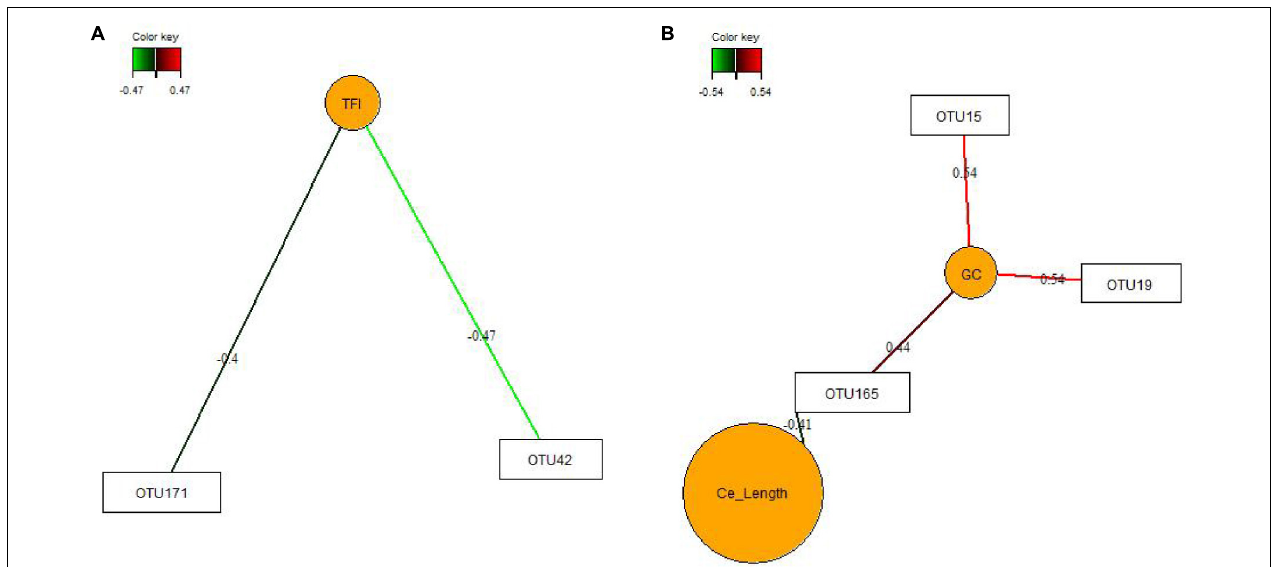
FIGURE 2 | Covariations between the relative abundances of the most discriminant bacterial operational taxonomic units (OTU; relative abundances > 0.01%) and total feed intake (TFI) and total body weight gain (TBWG) (A) and cecal characteristics (organ size and histo-morphology; B ). Associations were established using sparse partial least squares regression. Networks displayed graphically as nodes (OTUs and performance traits) and edges (biological relationship between nodes), with the edge color intensity indicating the level of the association: red, positive, and green, negative. Only the strongest pairwise associations are presented ( | r | > 0.40). Ce_Length, average length of the ceca; GC, goblet cell